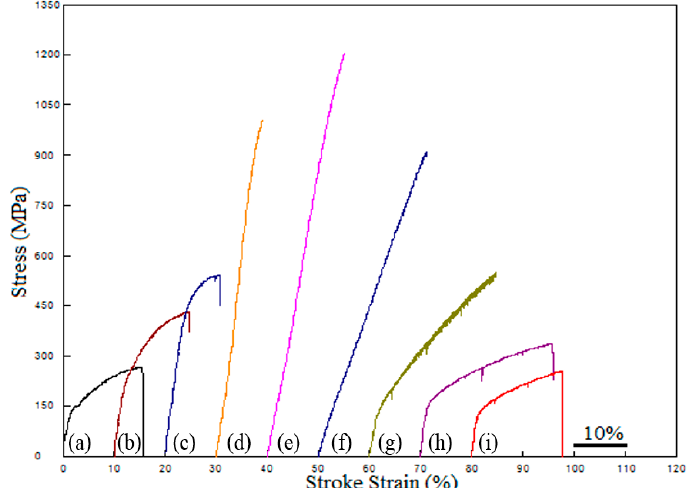
Figure 6. The stress–strain curves for powder metallurgy specimens at different percentages of Ni content (a—alloy 1, b—alloy 2, c—alloy 3, d—alloy 4, e—alloy 5, f—alloy 6, g—alloy 7, h—alloy 8, and i—alloy 9). Table 2. Mechanical properties of the compositions.